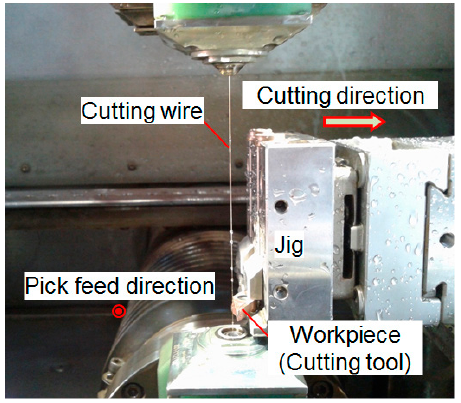
Figure 2. Experimental setup for texturing the tool cutting edge.